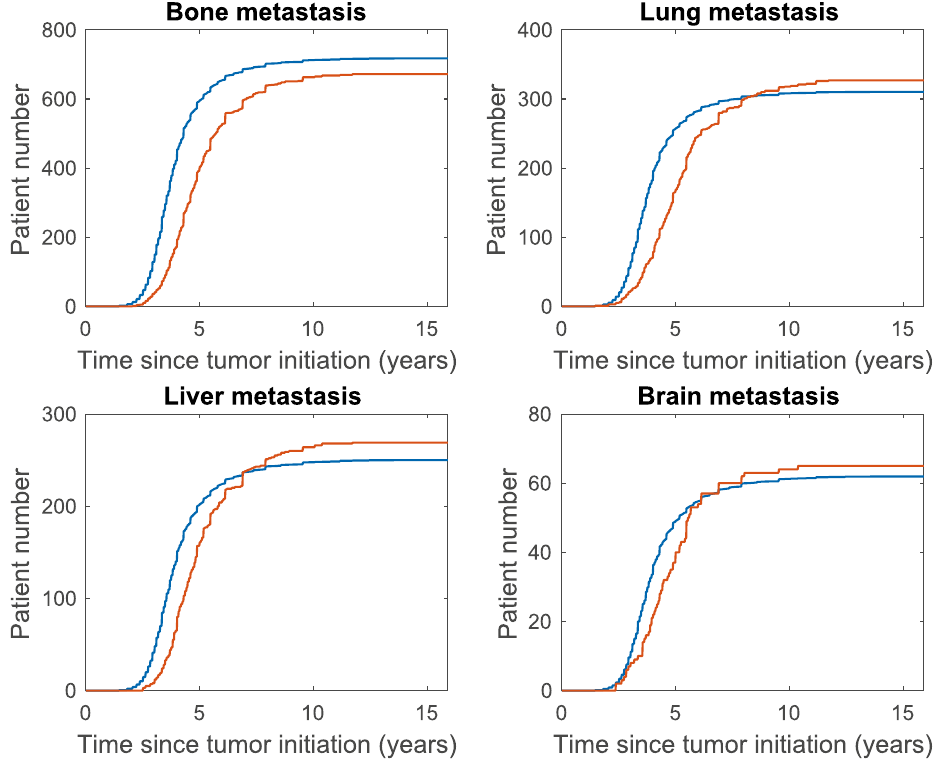
Figure 6. Model and one of the validation data sets using tenfold cross-validation. Cumulative number of patients versus tumor age. Data displayed in red and model prediction in